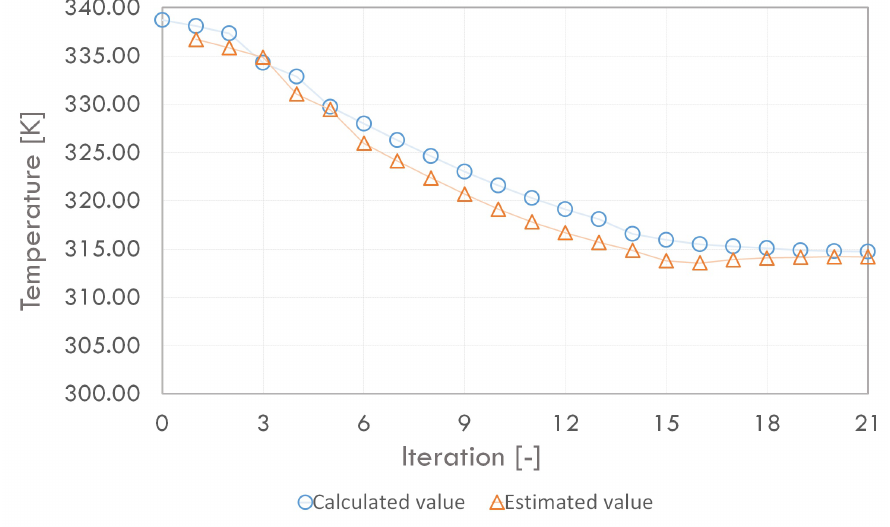
Figure 21. Temperature change behind the heat sink for 21